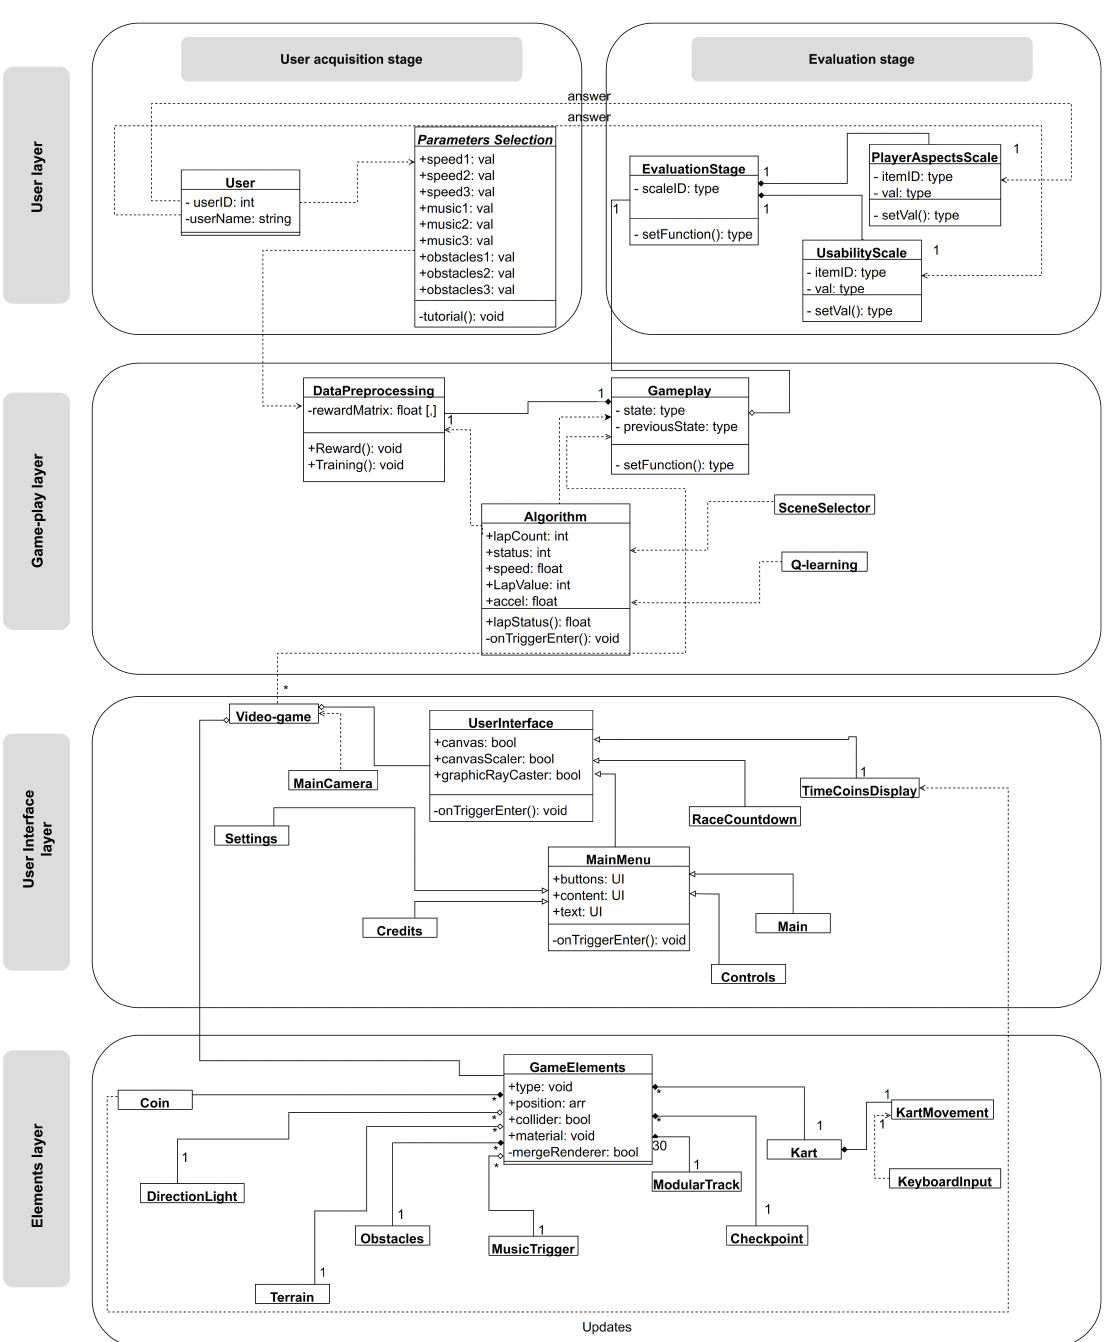
Figure A1. System class diagram. The virtual environment is made up of four main layers: user, game, user interface, and game elements. Each class shows the most important attributes and